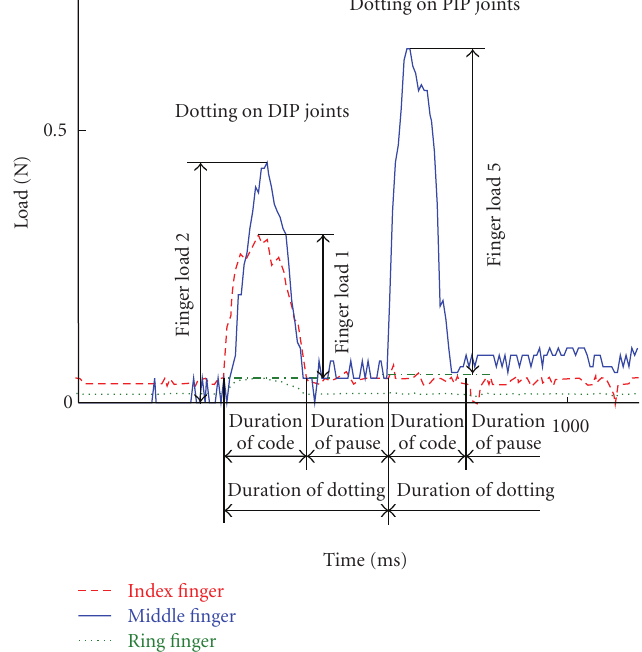
Figure 4: Calculation of durations and finger loads (one-handed Finger Braille).